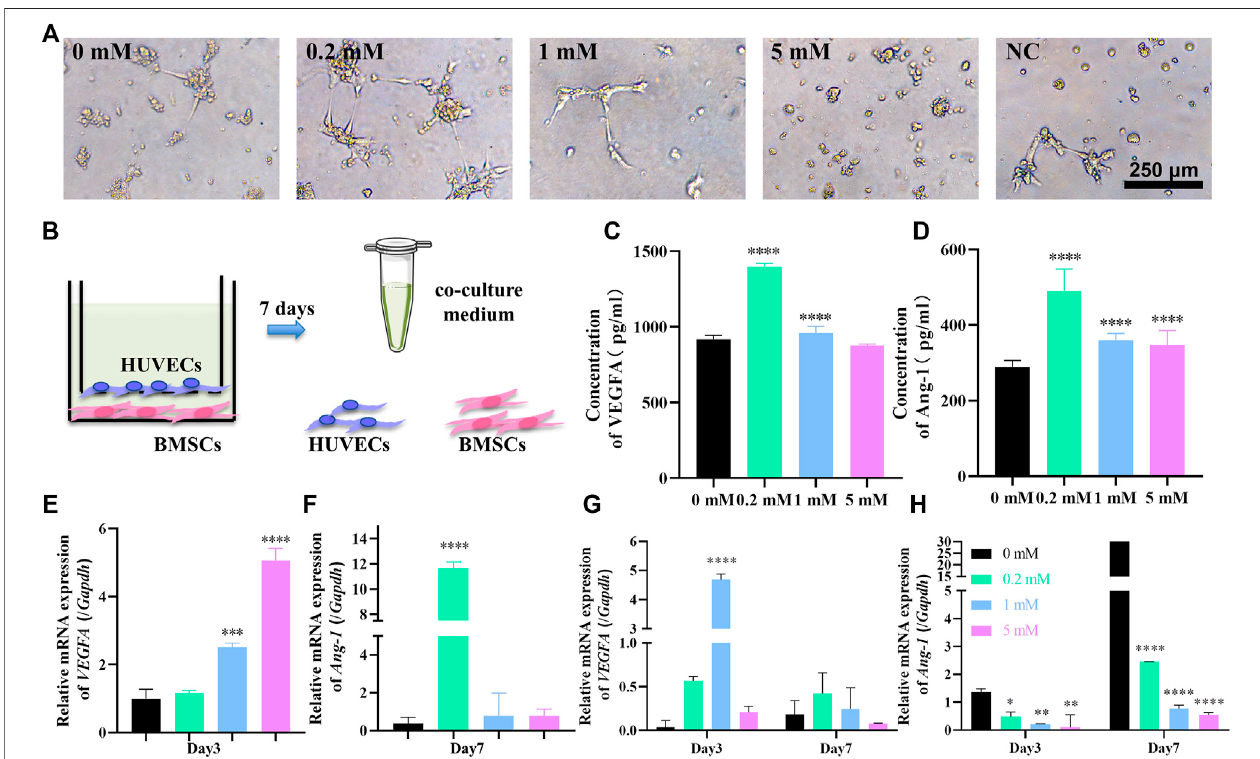
FIGURE2| SrstimulatestheangiogenesisabilityofHUVECsintheHUVECs – hBMSCsco-culturesystem. (A) Tubeformationassayfor3 hwithmediumcontaining 0,0.2,1,and5 mMSrcollectedatday7intheco-culturesystemandfreshco-culturemediumwithoutSrasnegativecontrol. (B) Theillustrationoftheco-culturesystem consisting of hBMSCs at the lower chamber and HUVECs at the upper chamber using a 1:1 mixture of α -MEM and ECM as co-culture medium; at day 7, the co-culture mediumwascollectedfortubeformationassayandELISAwhilethehBMSCsandHUVECswerecollectedforPCRassay. (C,D) ELISAofVEGFA (C) andAng-1 (D) in co-culture medium at day 7. (E) Relative expression of VEGFA gene of HUVECs cultured for 3 days and (F) relative expression of Ang-1 gene of HUVECs cultured for 7 days inthe co-culture system. (G,H) Relative expression ofVEGFA (G) and Ang-1 (H) genesin hBMSCs cultured for3 and 7 days in the co-culture system ( n =3, * p